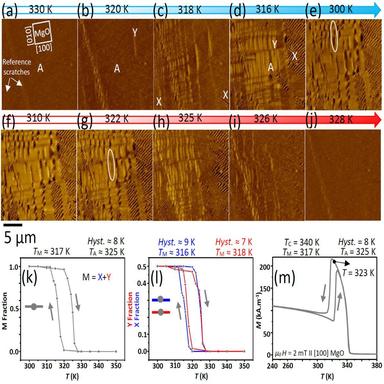
Zero-field phase transition: a-j) MFM images captured upon cooling (a-e) and upon heating (f-j), showing the formation, coalescence and annihilation of the X- and Y-type twinning configurations. The position of the reference scratches and the direction of the MgO substrate are labeled in (a). Some of the X- and Y-type regions as well as the austenitic areas (A) are labeled. k) The phase transition curves constructed from the MFM images, showing the martensitic fraction of the scanned area over cooling and h